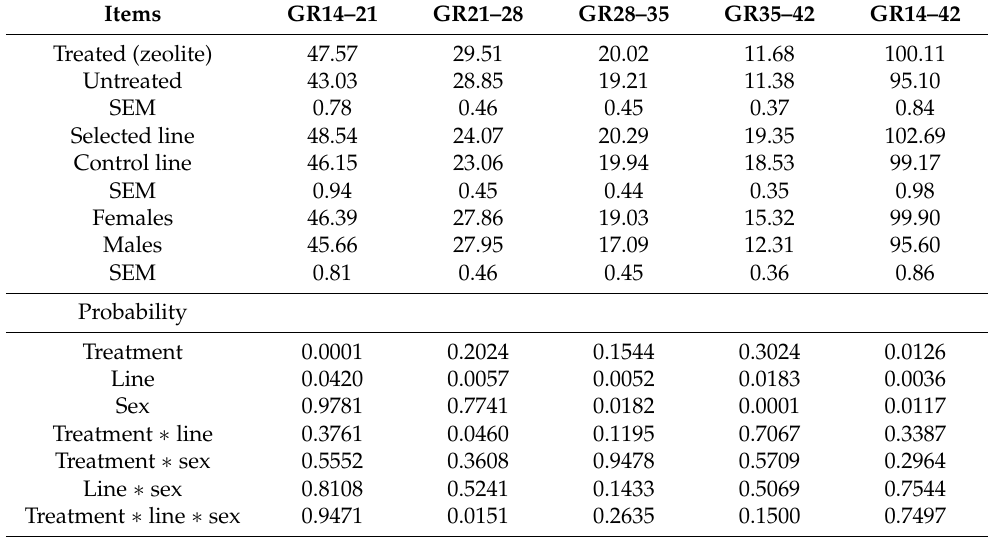
Table 3. Least square means for the growth rate (GR, %) during different periods studied as affected by treatment, line, and sex